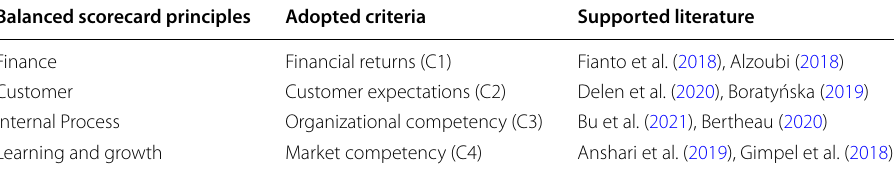
Table 1 Balanced scorecard-based multidimensional due diligence for green energy